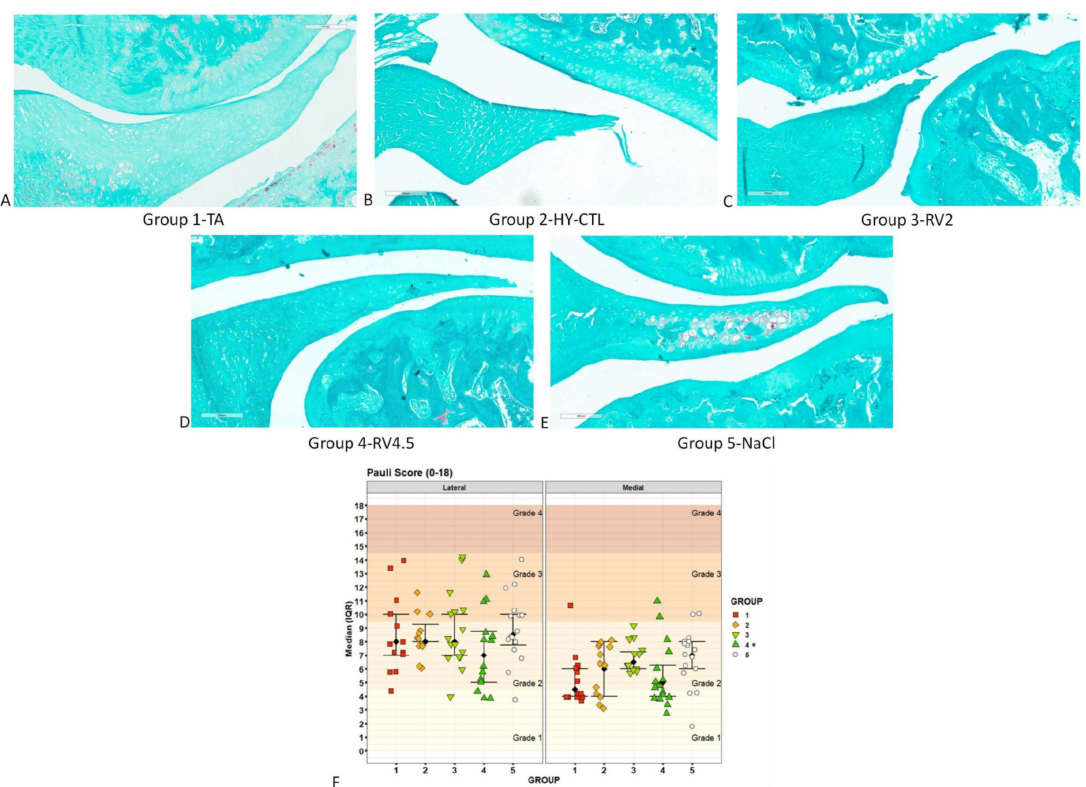
Figure 5. Histopathological assessments of menisci. Histological images of the lateral aspect of menisci treated with i.a injection of TA ( A ), HY-CTL ( B ), RV2 ( C ), RV4.5 ( D ) and NaCl ( E ). Safranin O / Fast Green staining. Magnification 15 × , bar = 200 µ m. ( F ) Scatter plot of Pauli score results for the histological grading of menisci for each treatment measured at the lateral and medial knee joint compartments; black square dots indicate the median and error bars indicate IQR. The selected cumulative link models (CLM) (likelihood ratio test: χ 2 = 43.7, p < 0.0005) highlighted significant e ff ects of ‘treatment’ ( χ 2 = 13.0, p = 0.011) and ‘joint compartment’ ( χ 2 = 31.9, p < 0.0005) factors on Pauli score. Post-hoc pairwise comparisons (1 symbol: p < 0.05; 2 symbols: p < 0.005; 3 symbols: p < 0.0005): * All treatment groups versus NaCl. Significantly lower Pauli score results were found for the medial joint compartment than for the lateral one ( − 29%, p < 0.0005). Black arrowheads: undulation; red arrowheads: fibrocartilaginous